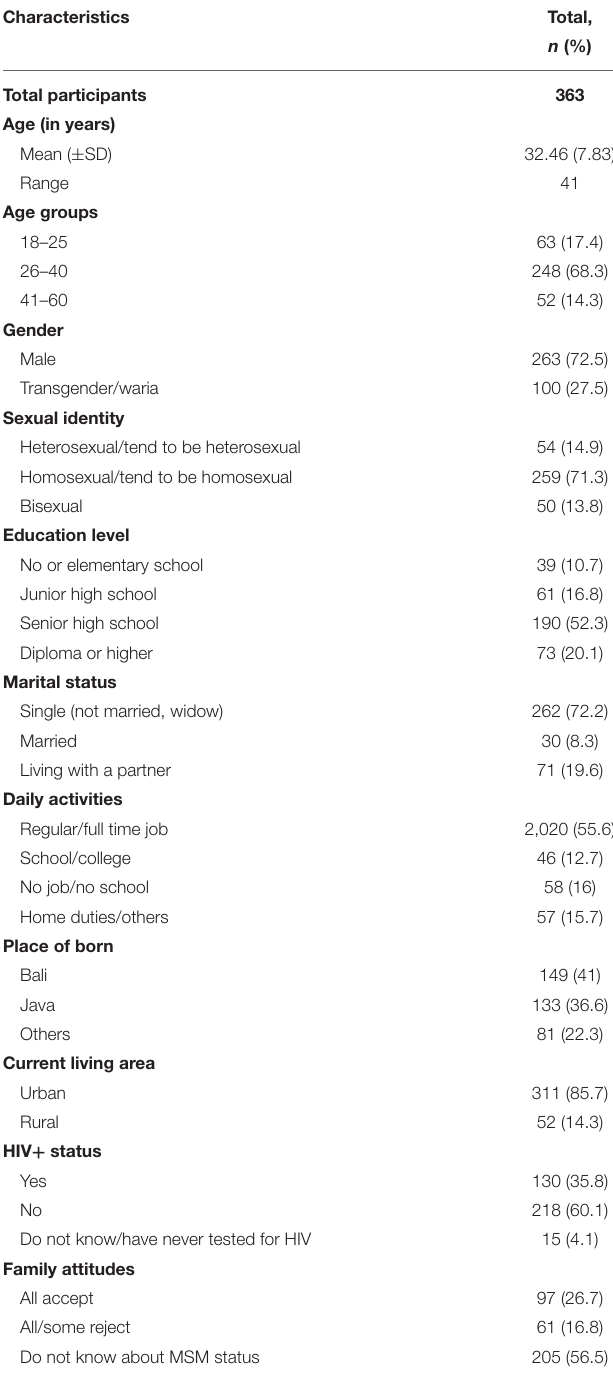
TABLE 1 | Characteristics of the study